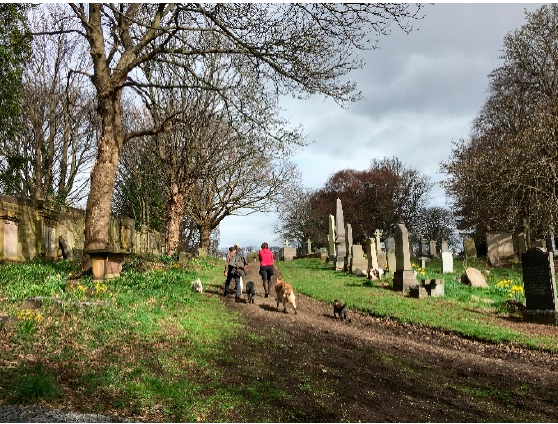
Figure 4. Results of behavioural observations. ‘Others’ include doing voluntary work, meditation, cycling, running, taking photographs, watching birds, and flying drones.